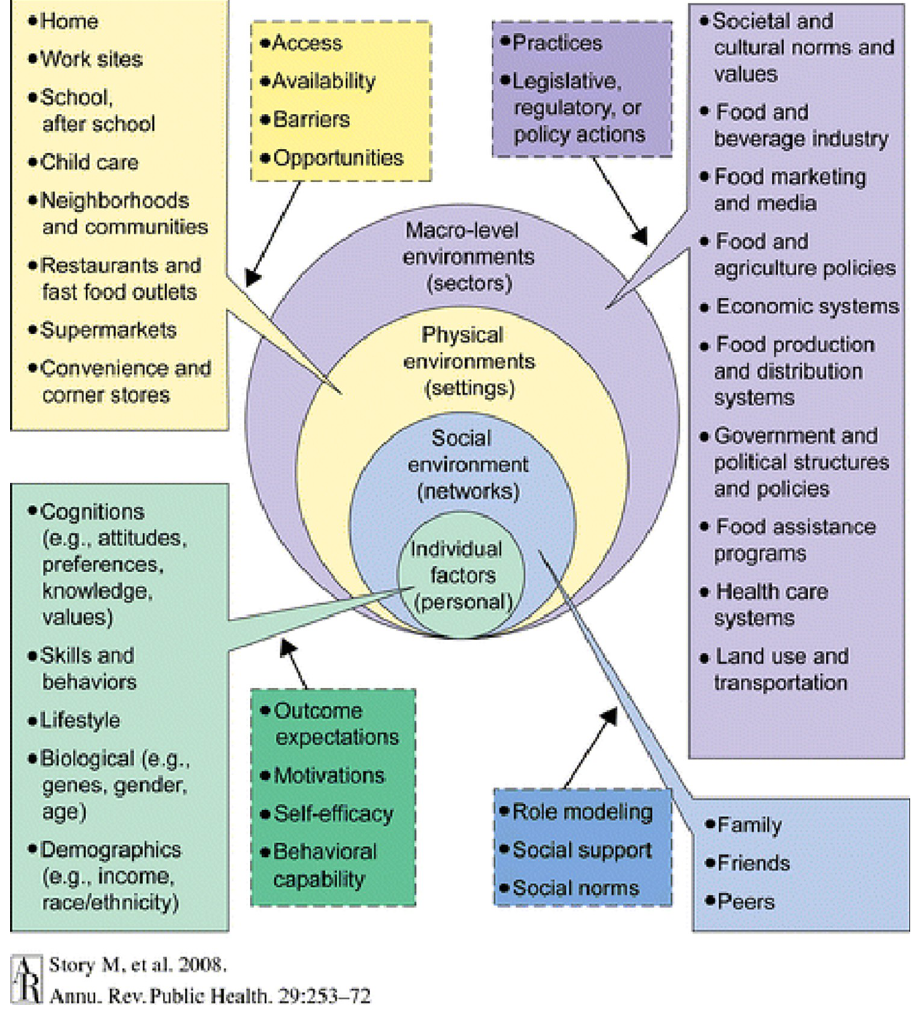
Fig 1. Ecological framework from Story et al,